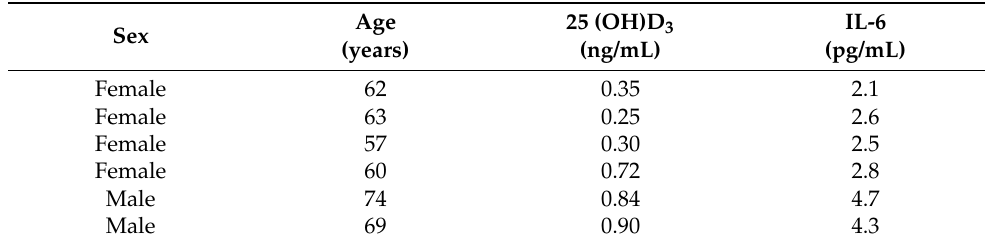
Table 1. Serum levels of 25(OH)D 3 and IL-6 determination in COVID-19 patients with extremely low